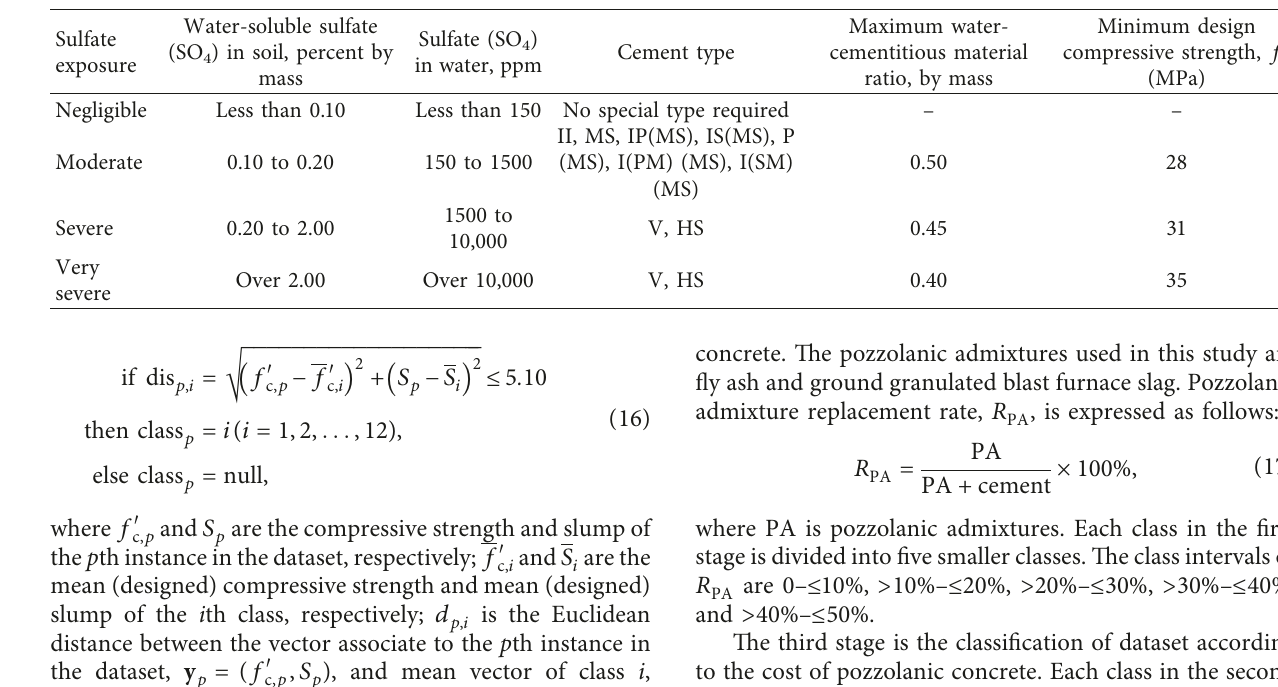
Table 8: Requirements for concrete exposed to sulfates in soil or water “Table 8 is reproduced from Kosmatka et al. [39] (under the creative commons attribution license/public